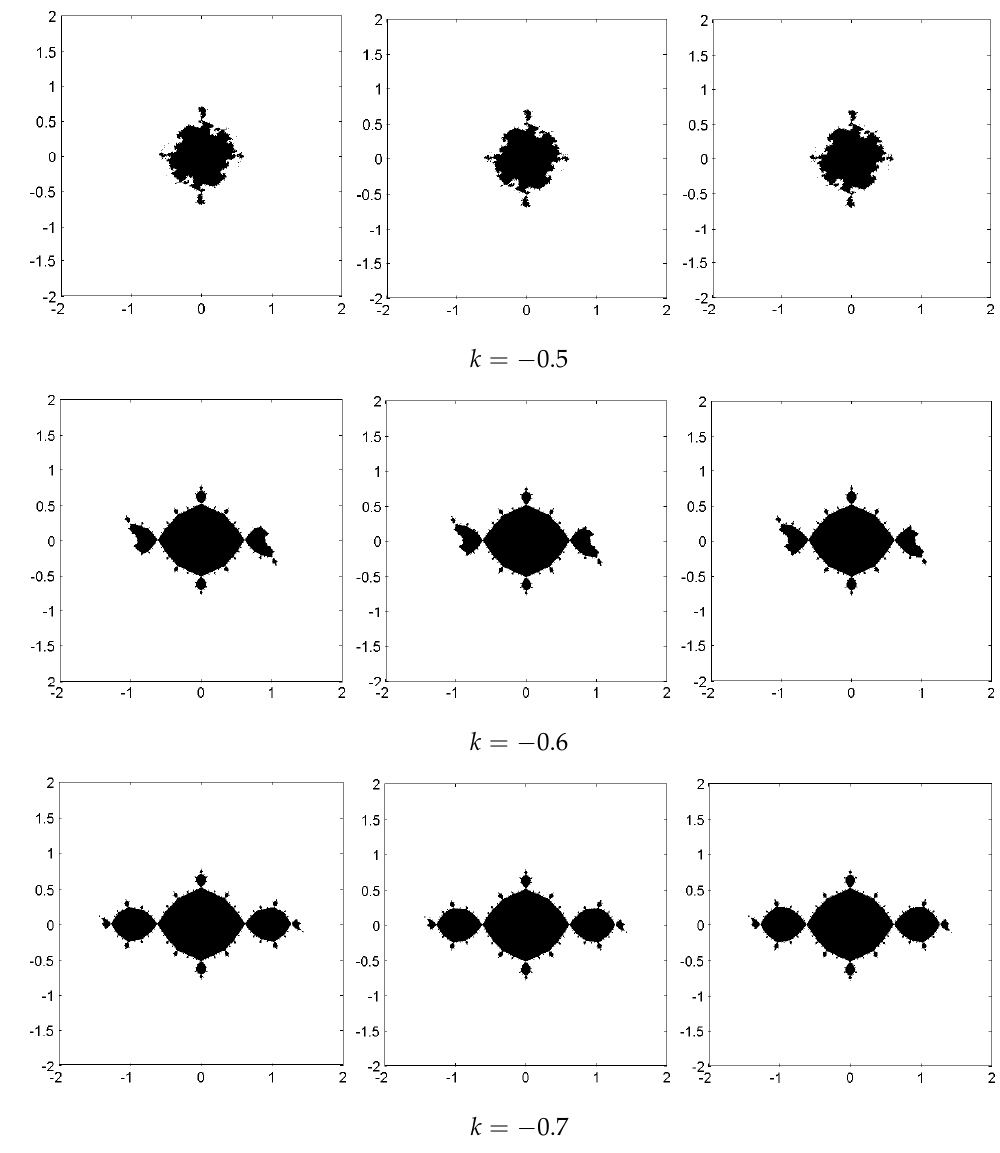
Figure 4. Consensus progress of the leader Julia set and the follower Julia sets of z ( n + 1 ) = z 2 ( n ) + c with different values of the control parameter k